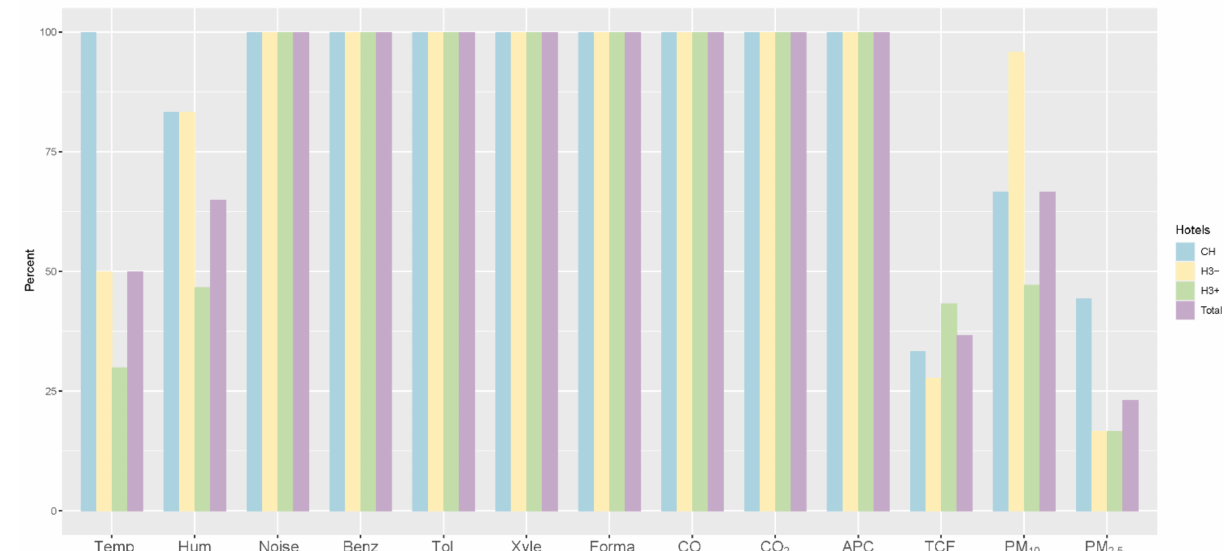
Figure 2. The compliance of the environmental quality of hotels. Note: Temp (temperature), Hum (humidity), Benz (benzene), Tol (toluene), Xyle (xylene), Forma (formaldehyde), APC (aerobic plate count), TCF (total count of fungi). CH (chain hotels), H3 − (hotels below 3-star), H3+ (hotels above